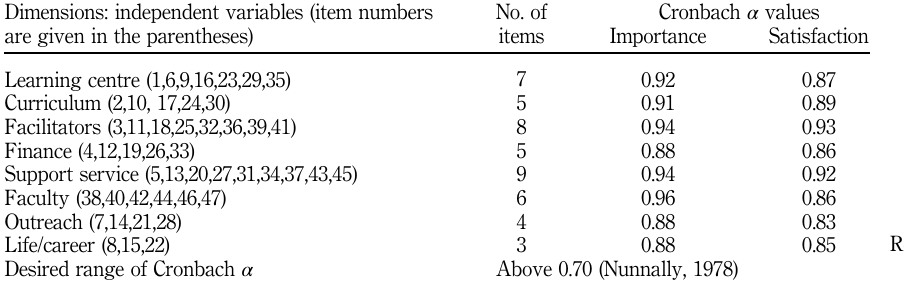
Table II. Reliability test